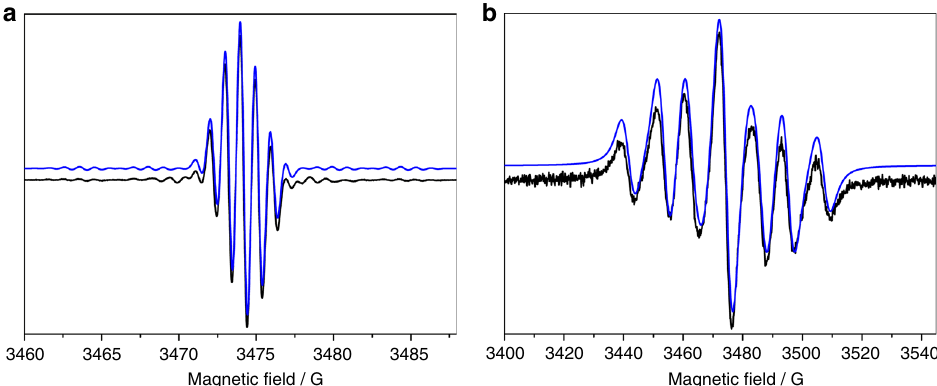
Fig. 5 Spectroscopic investigations of 2 Mes with Cp 2 Co in CH 2 Cl 2 at room temperature. a Experimental X-band EPR spectrum of 2 Mes (cid:129) ‒ (black trace) recorded as a fl uid solution in CH 2 Cl 2 at room temperature. The simulated spectrum is given in blue and parameters used for the simulation are listed in Supplementary Table 2. b Experimental X-band EPR spectrum of 2 Mes (cid:129) ‒ - 13 C (black trace) recorded as a fl uid solution in CH 2 Cl 2 at room temperature. The simulated spectrum is given in blue and parameters used for the simulation are listed in Supplementary Table